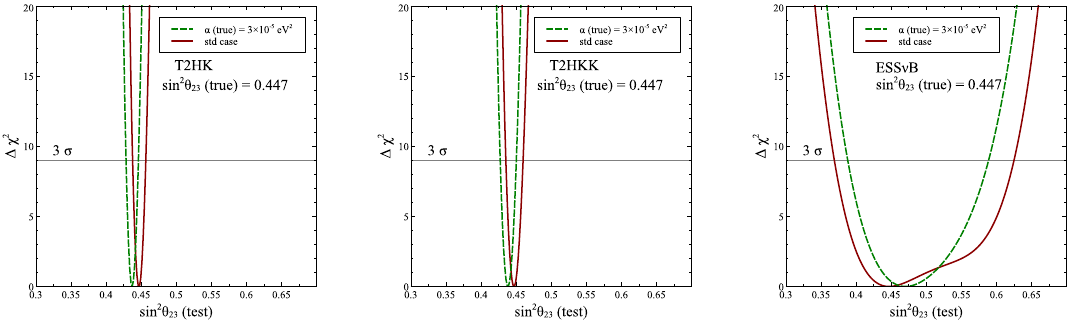
Figure 8 . The ∆ χ 2 as a function of θ 23 (test) assuming sin 2 θ 23 (true) = 0 . 447 . The left, middle and the right panels are for T2HK, T2HKK and ESS ν SB respectively. The dark red solid curves are for standard cases and the green dashed curves are for the cases where α is assumed to be 3 × 10 − 5 eV 2 in the simulated data but decay is not considered in the